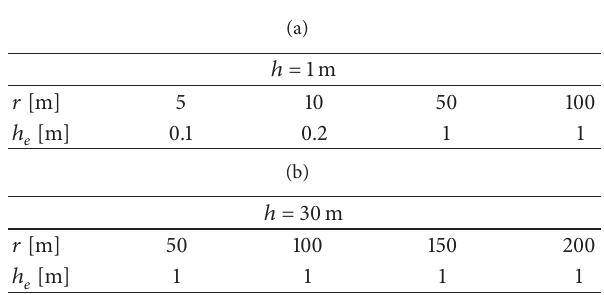
Table 2: Geometry values used in the simulations performed to fix 𝑟